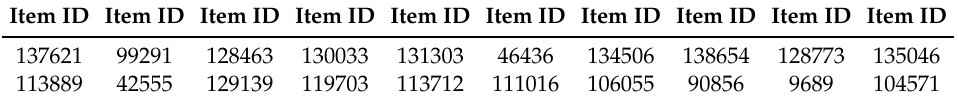
Table 5. 20 deleted target item IDs.